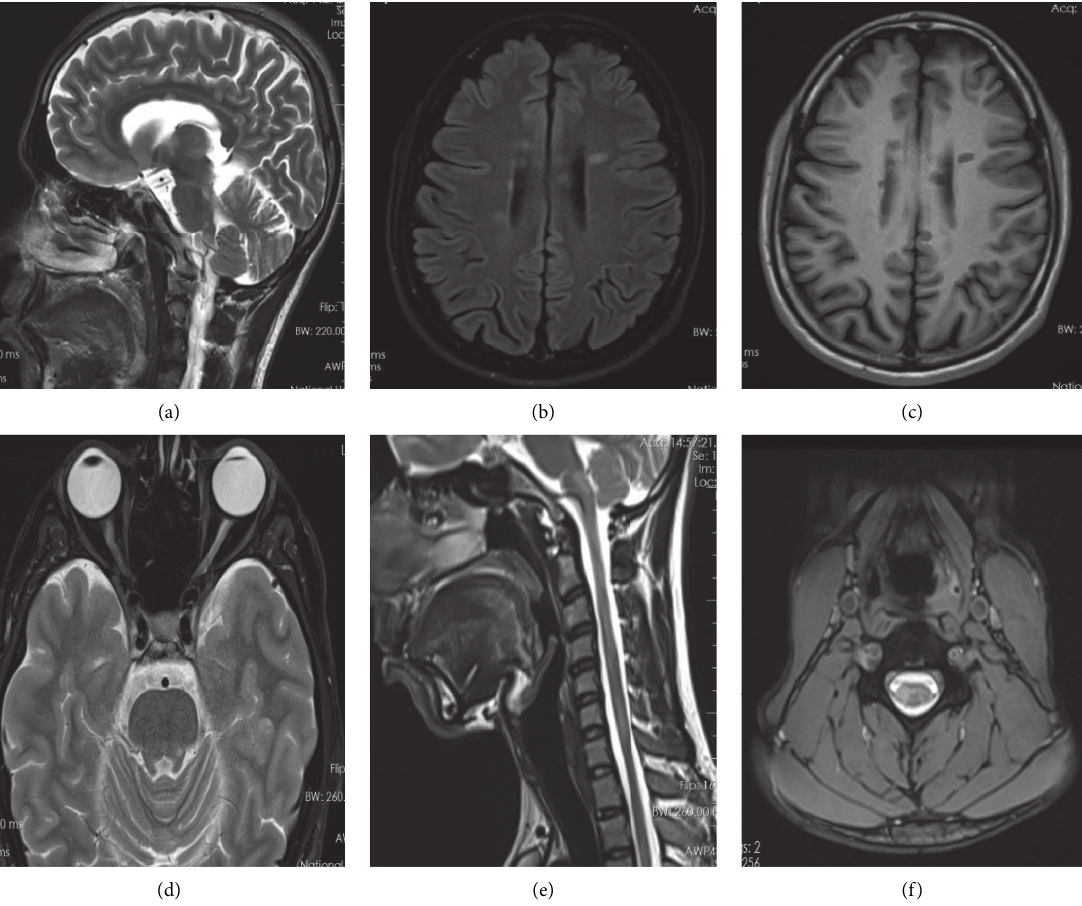
Figure 1: MRI brain and spine of son: (a) T2 sagittal, (b) T2 FLAIR axial, (c) T1 axial images demonstrate numerous T2 high signal T1 low signal white matter lesions arranged perpendicular to the bilateral lateral ventricles suggesting Dawson’s fingers. Lesions involve the corpus callosum, callasoseptal interface, and posterior fossa. T2 axial image of the orbits (d) shows right optic neuritis. Cervical spine T2 sagittal (e) and axial (f) images demonstrate multiple short segment T2 high signal lesions without significant spinal cord edema and expansion. Lesions are not contrast